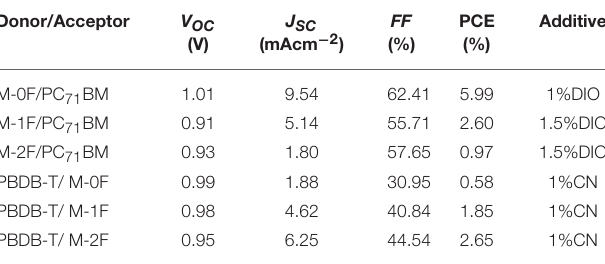
TABLE 2 | Device performance of M-0F, M-1F, and M-2F with PC 71 BM as acceptors.